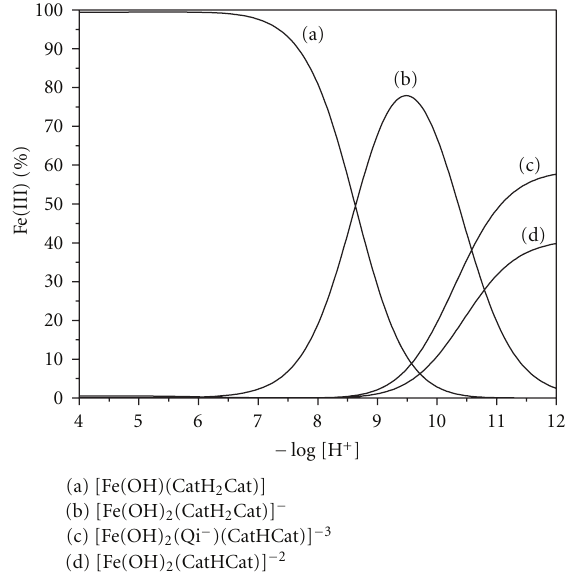
Figure 4: Interaction distribution curves of a DHI melanin solution containing 2.00 mM of DHI melanin (in a 2.0:0.5 ratio of catechol:quinone-imine) and 0.99 mM of Fe(III) ions at 25.0 ◦ C.